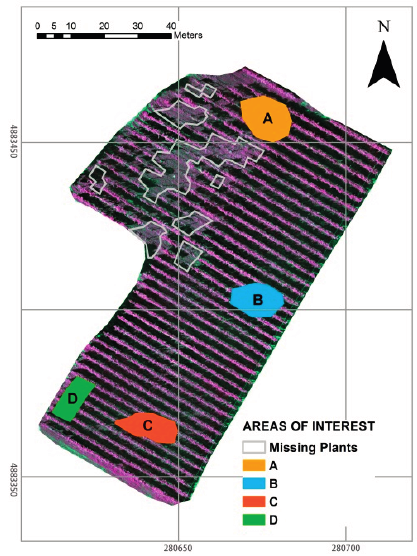
Figure 8. Map of the no-vine plant zones and the areas of interest used for the statistical analysis. Area A and Area D cover a region with better vegetation conditions, while Area B and Area